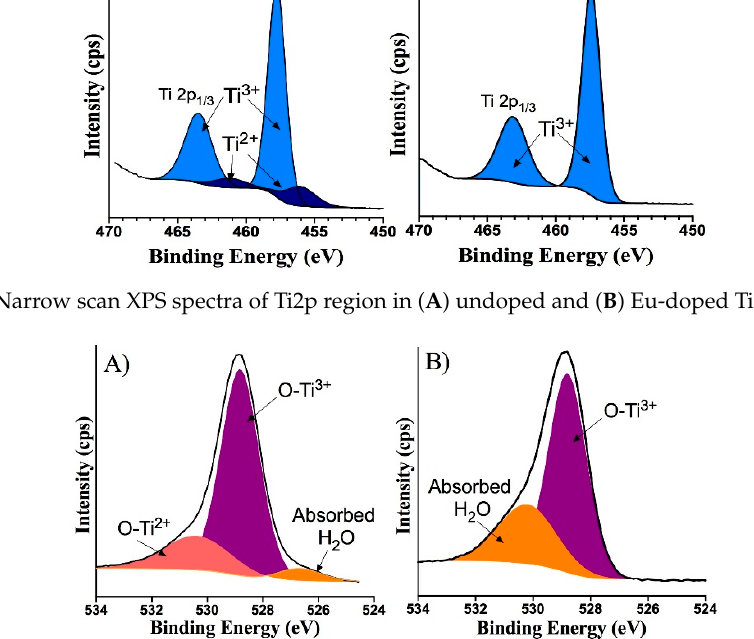
Figure 6. Narrow scan XPS spectra of( A ) Eu 3d and ( B ) Eu 4d region in Eu-doped TiOx thin film.